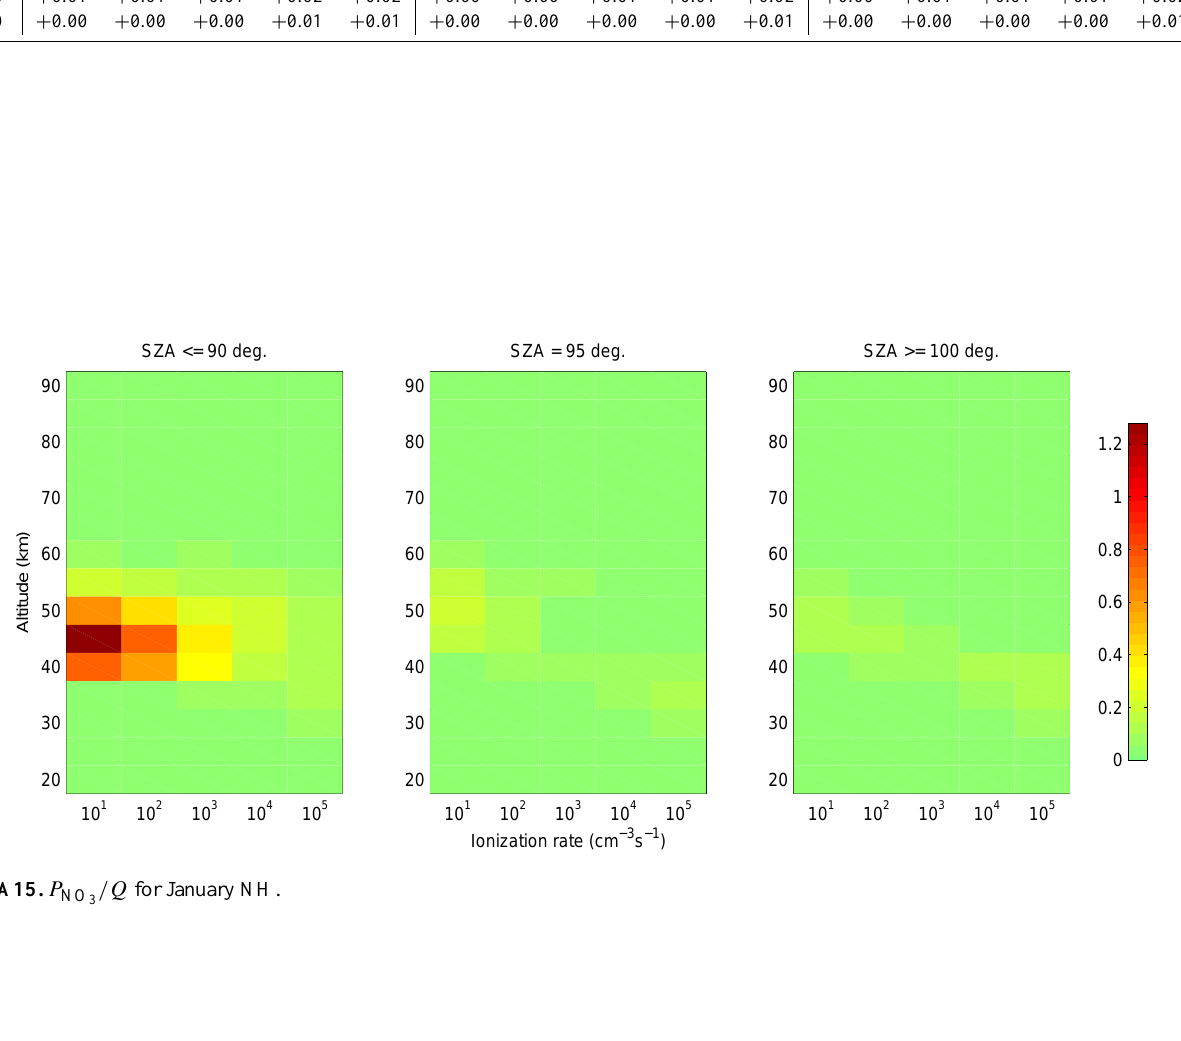
/Q for January 3